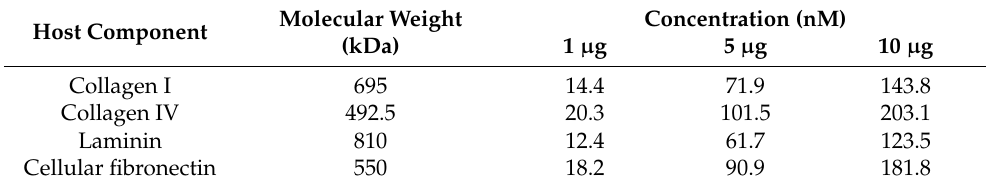
Table 3. Host components, with molecular mass (kDa), concentration (nM) and weight ( µ g), added to recombinant protein blocking assay using cell